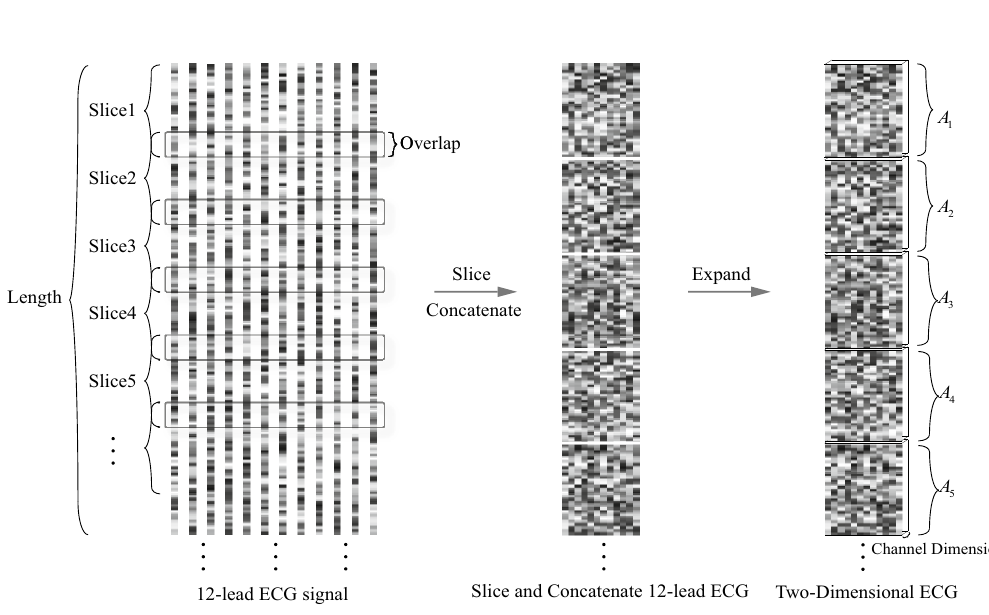
Figure 1. Two-dimensional and expend dimension